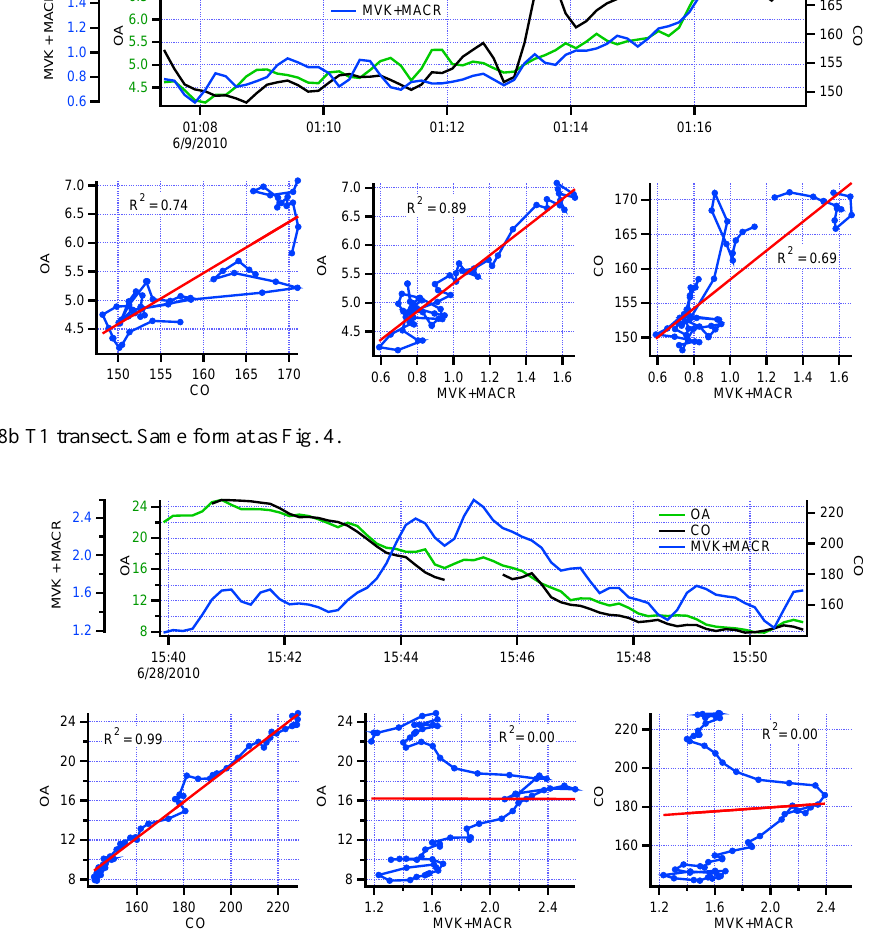
CO and MVK + MACR as judged by the standardized re- gression slopes. By most measures an R 2 of 0.89 for OA vs. MVK + MACR on the 608b City-Edge transect would be considered excellent. But, because of the slightly higher R 2 for OA vs. CO (0.94) and the high correlation between CO and MVK + MACR (0.89), a bilinear model assigns most of the variance in OA to CO. An opposite conclusion is reached for the 608b, T1